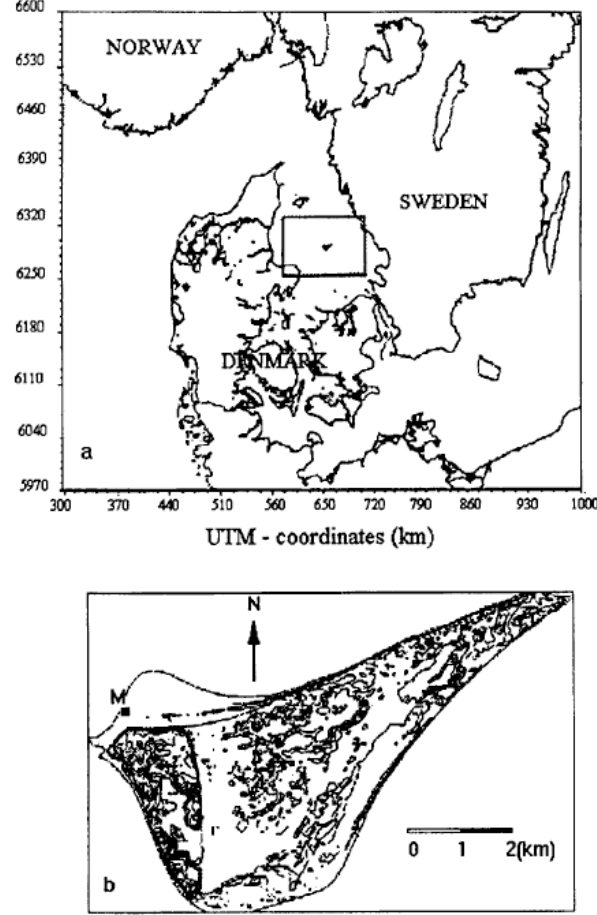
Fig. 1. In (a) , a map showing the location of Anholt Island in the UTM horizontal position representation; in (b) , the symbol M gives the position of the meteorological station on Anholt Island. These maps are also published as Fig. 1 in Sempreviva and Gryning